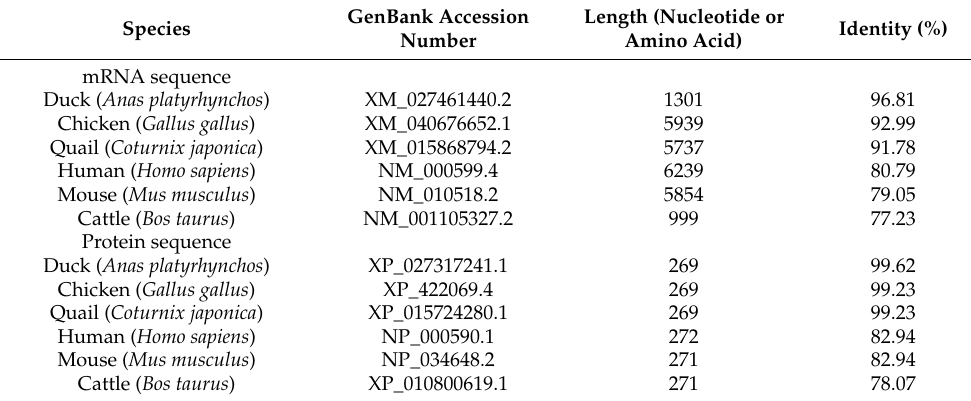
Table 3. Comparisons of goose IGFBP5 mRNA or amino acid sequences with their counterparts from some other